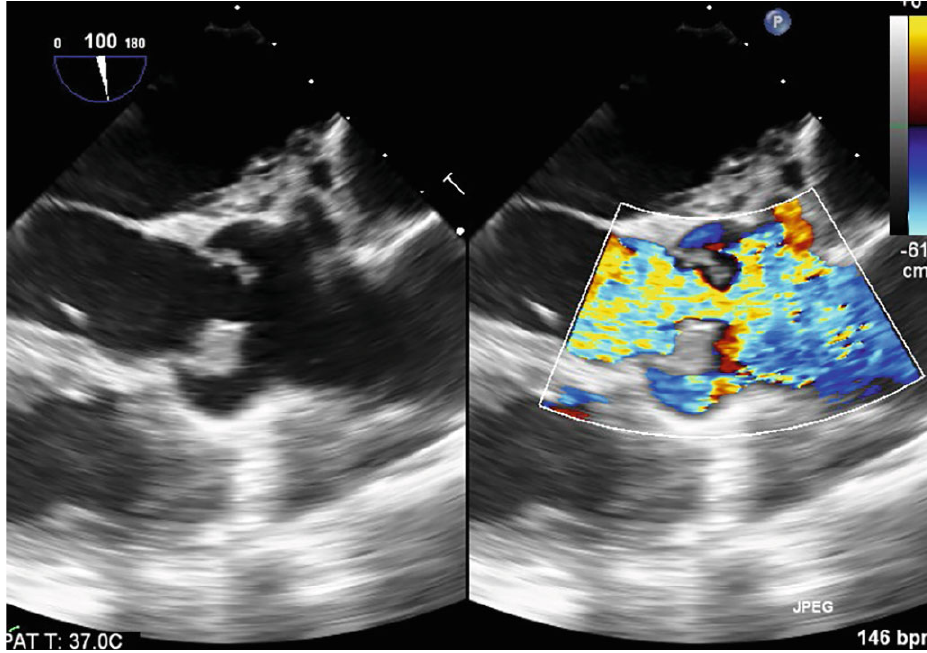
Figure 2: TEE from transgastric long axis view with beam path at 120 degrees showing aortic valve echodensity. Color Doppler demonstrates severe AI. Yellow arrow points to subaortic membrane.